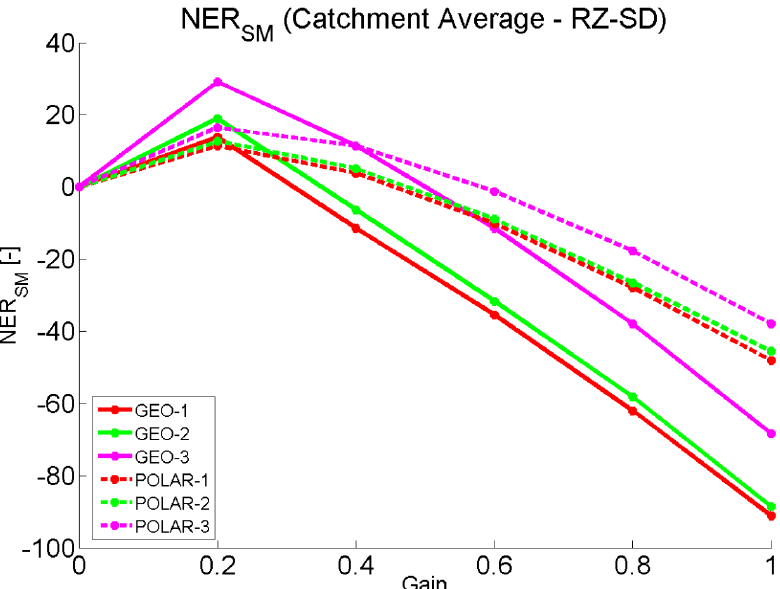
Figure 9. Synthetic experiment: impact of SM-DA of GEO SAR and POLAR SAR products on hourly RZ-SD data. OL value, in terms of RMSE, is 0.079 [-]. The RMSE was computed only in areas where SM data could be retrieved from SAR acquisitions.